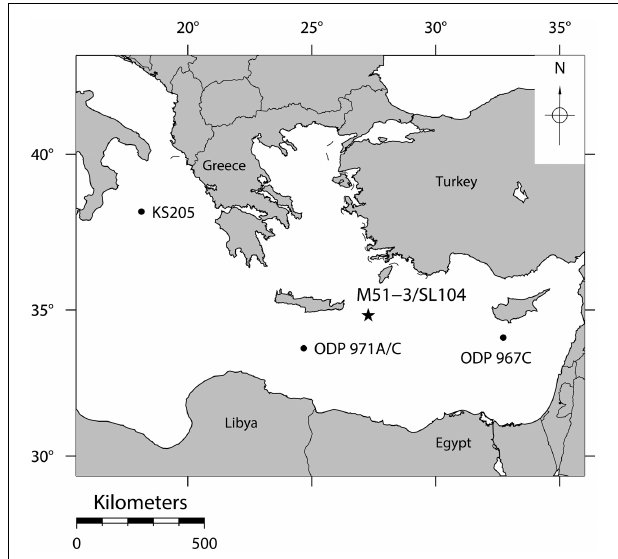
FIGURE 1 | The position of core M51-3/SL104 in the Pliny Trench about 100 km east-south-east of Crete where the reaction of planktonic Foraminifera to stress has been studied. Positions of other cores, where the same local extinctions of the species investigated here have been observed (Cane et al., 2002), are indicated by black